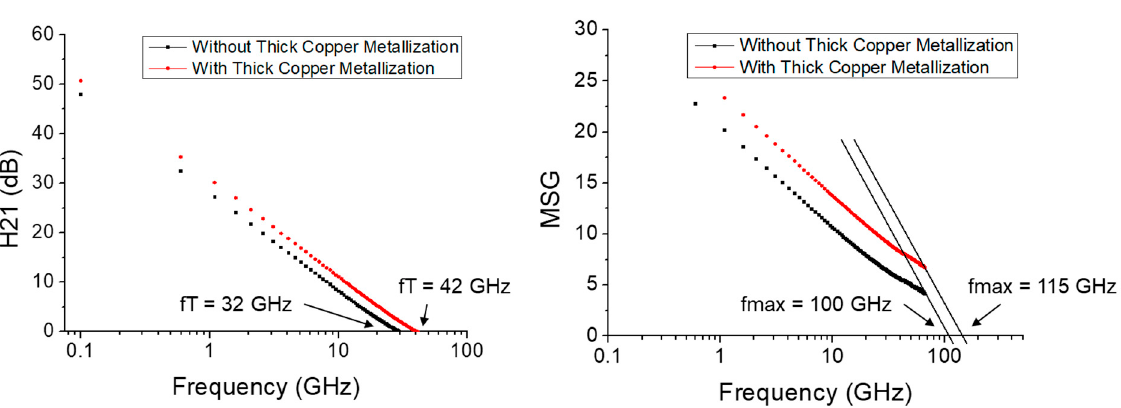
Figure 8. Measured small-signal performance up to 67 GHz with the extracted fT and fmax values for the devices with and without thick copper metallization.